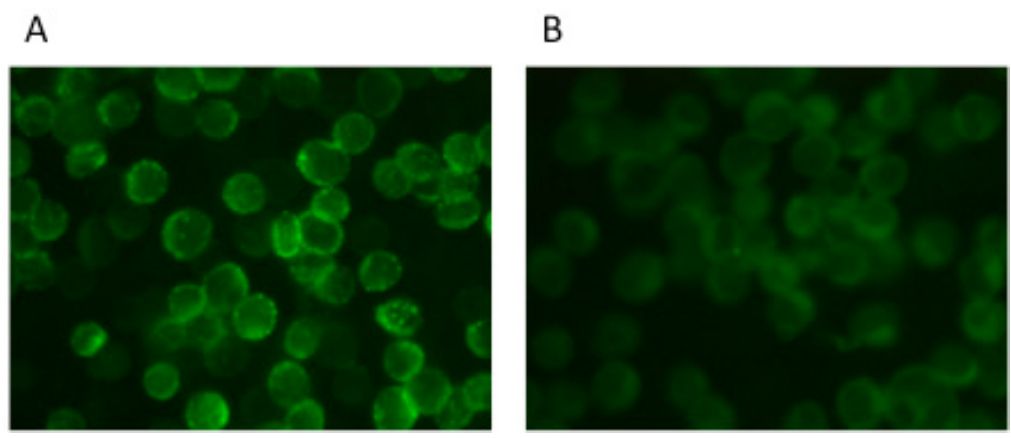
Figure 2. Staining patterns of the LASV-rNP-expressing HeLa cells obtained from the